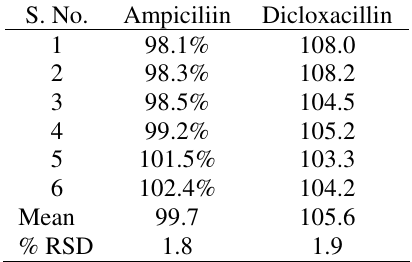
Table 1. System suitability data for method precision of amiciline and dicloxacillin capsule dosage